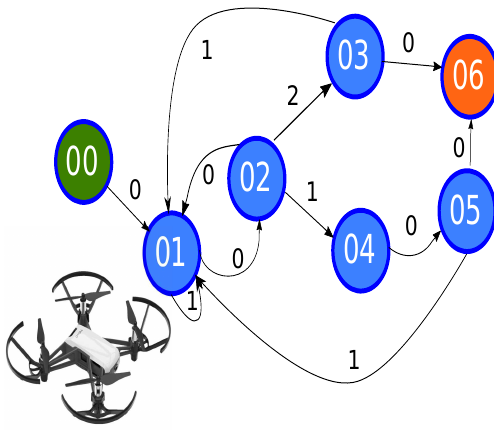
Figure 22. States to control MAV . Table 3. Description of states diagram for flying a